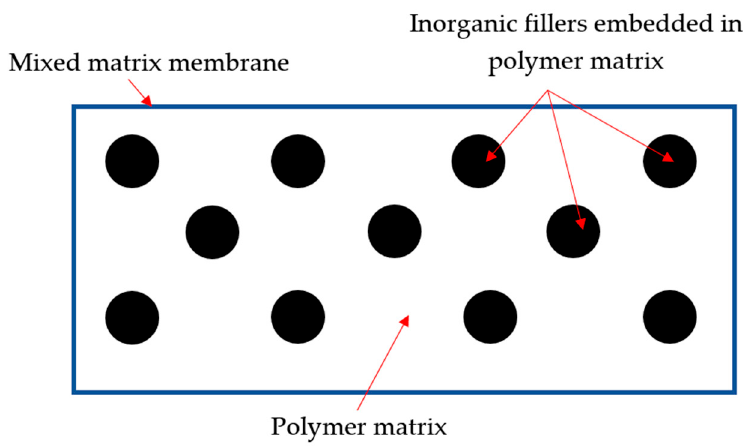
Figure 1. An illustration of an inorganic filler incorporated in a polymer matrix. Reprinted/adapted with permission from Aroon et al. [18] (2010) Elsevier Copyright.